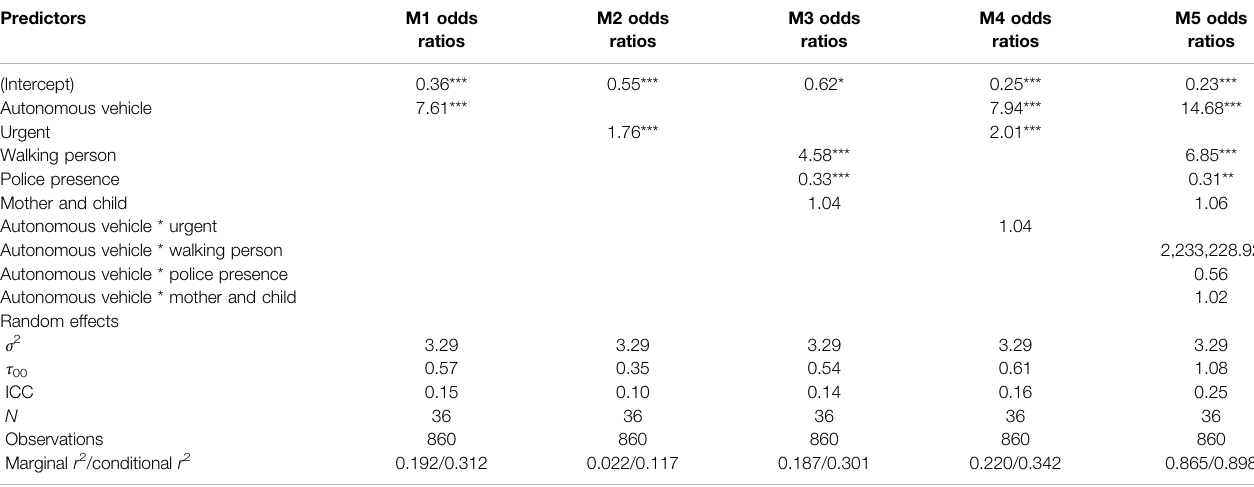
TABLE 1 | General results for the effect of vehicle type, task urgency, and social control on crossing decisions. Predictors